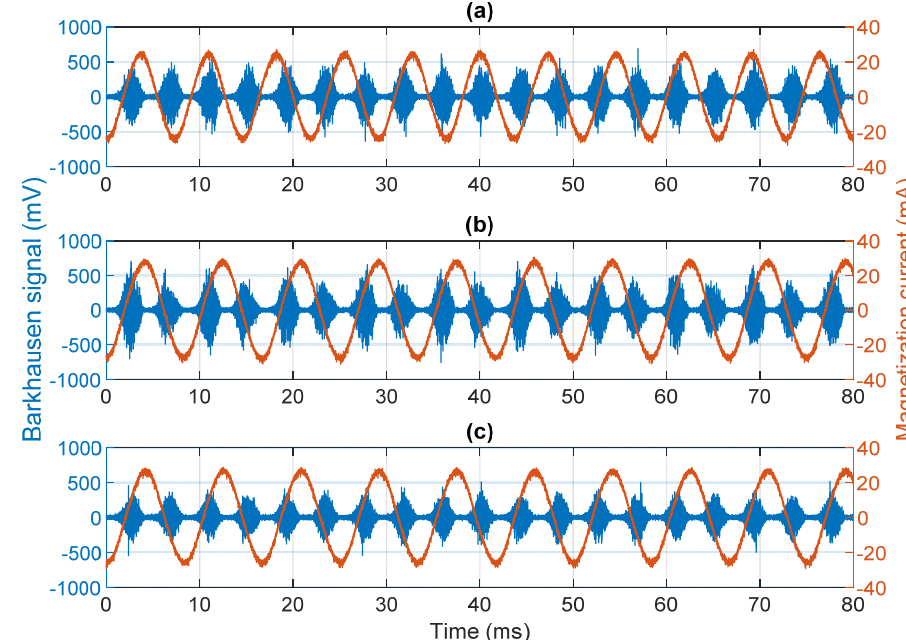
Figure 4. Top ( a ) Plot of Longitudinal MBN measurement for sample 23. Middle ( b ) Plot of Transversal MBN measurement for sample 23. Bottom ( c ) Plot of Longitudinal MBN measurement for sample 26. Sinusoidal signals for both relate the input magnetizing current resulting from a given set of input parameters (2 V and 120 Hz).